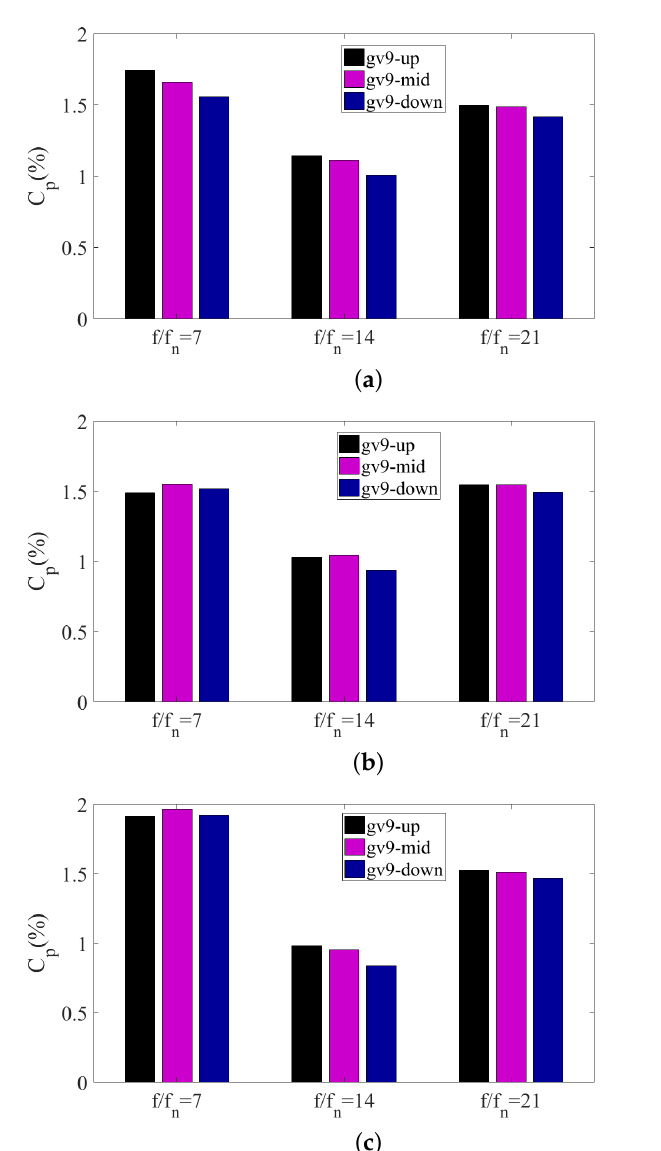
Figure 16. Amplitudes of pressure fluctuations at the monitoring points along with the vertical